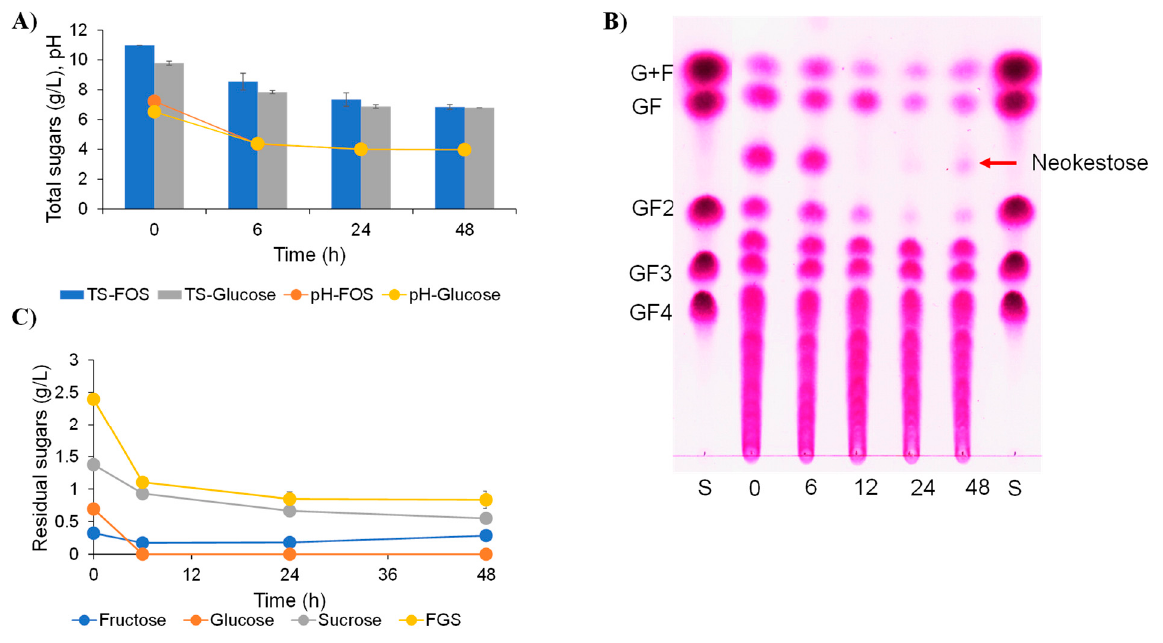
Figure 4. Profile of residual total sugars, pH values compared with the control (glucose) ( A ), TLC chromatogram ( B ) and residual fructose, glucose, sucrose and the sum of the residual sugars fructose, glucose and sucrose (FGS) ( C ) during cultivation of inulin-FOSs extract at 37 °C for 24 h.